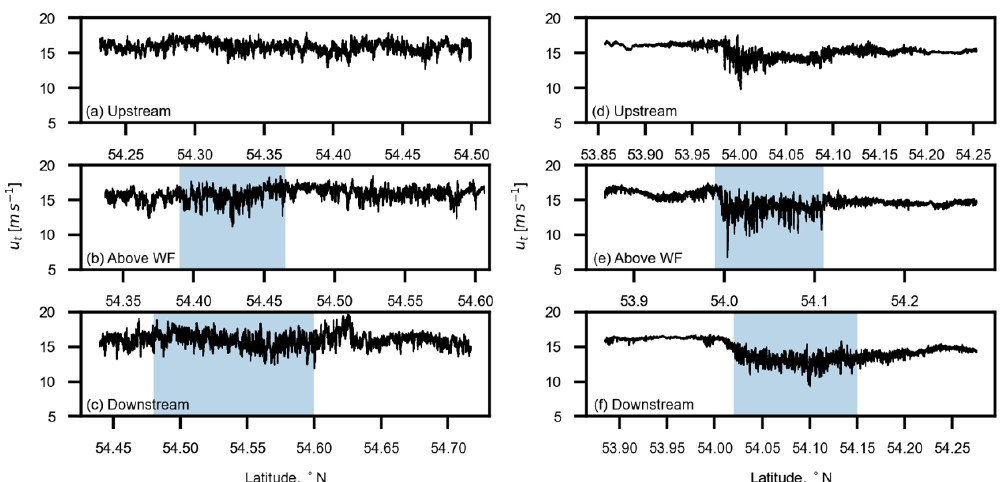
Figure 4. The horizontal wind speed component transformed in the mean wind direction for (a–c) flight 32 (altitude: 200ma.m.s.l.), weak stratification and (d–f) flight 39 (altitude: 250ma.m.s.l.), strong stratification. The blue shaded areas represent wind farm boundaries in (b)